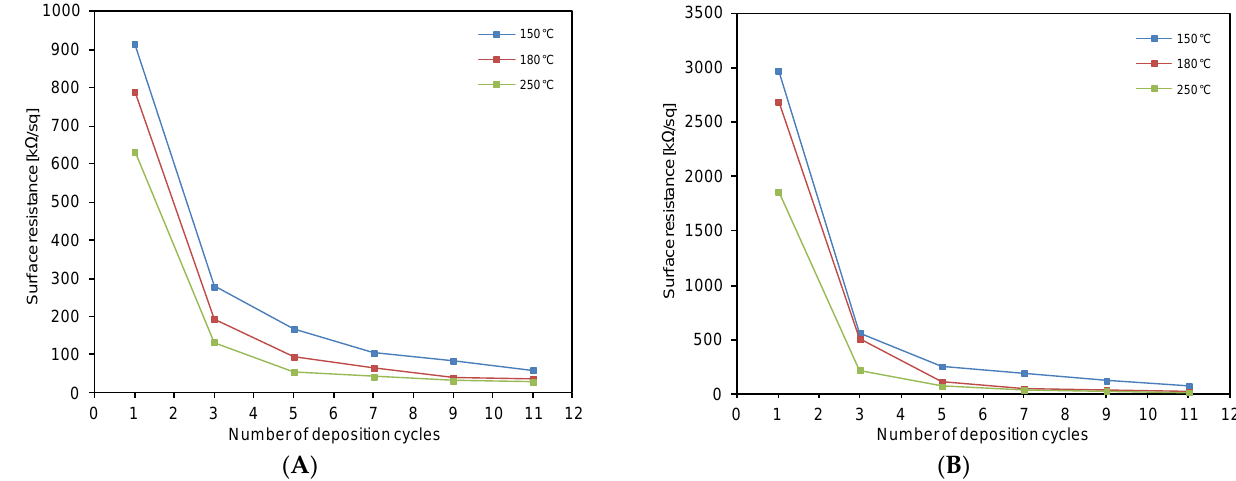
Figure 5. The dependence of surface resistance of multilayer films (rGO + /rGO − ) n on the number of deposition cycles; ( A ) on quartz plates, ( B ) on polyimide foil after thermal reduction at different temperatures (150 °C, 180 °C, 250 °C).